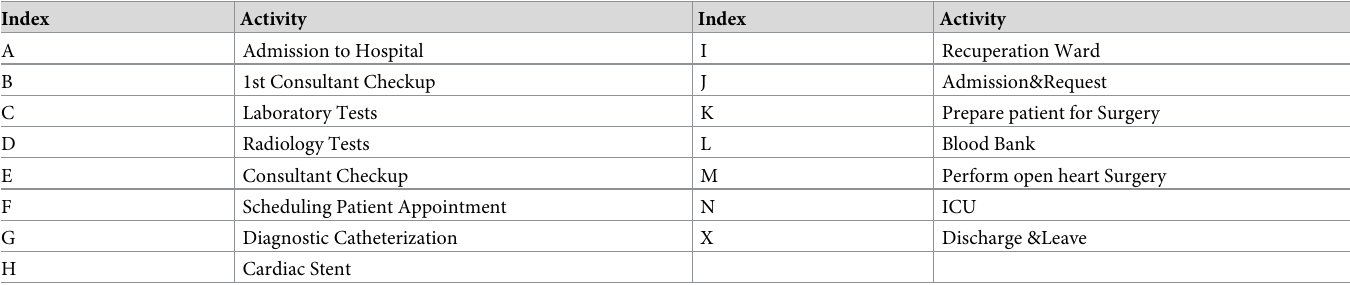
Fig 10. BPMN models generated after clustering patients upon on the interest of hospital’s experts. (a) Cardiac Stent and Diagnostic Catheterization (b) open heart surgery (c) without any surgery just a medication. https://doi.org/10.1371/journal.pone.0281836.g010 process model one event at a time. The error in replay happens when there are ignore/skip an event in the log or to ignore/skip task in the process model. This drawback is fixed by later alignment techniques in researches of [35, 36], where the closed corresponding trace that can be parsed by the model is identified for each trace. This paper used the Prom plugin named “Replay a log on petri net for conformance analysis” that was derived from the align- ment-based conformance checking in [35, 36]. This plugin takes the petri net that generated from the four discovery miners and the event log after filtering, the outputs from this plugin Table 4. Index of the